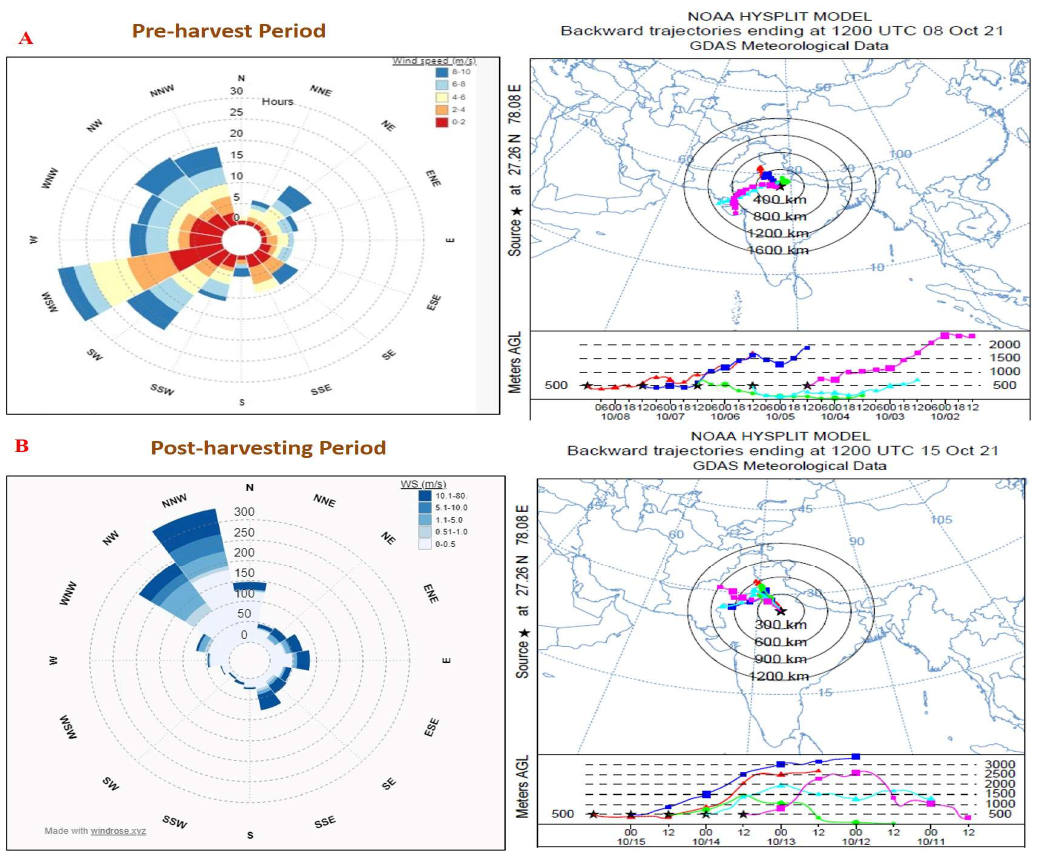
Figure 7. Air backward trajectory and wind direction during the ( A ) pre-harvest period and ( B ) post-harvest period at the study site.